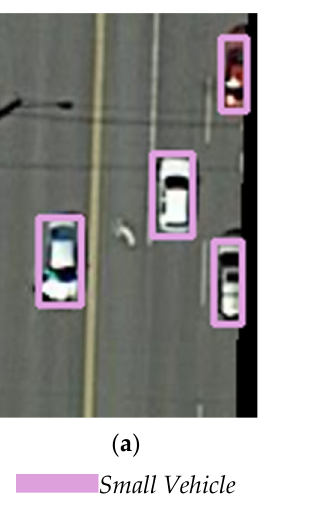
Figure 13. An example of R2CNN and TPR-R2CNN detection results: ( a ) the detection result of R2CNN and ( b ) the detec- tion result of TPR-R2CNN (the score threshold is 0.05).